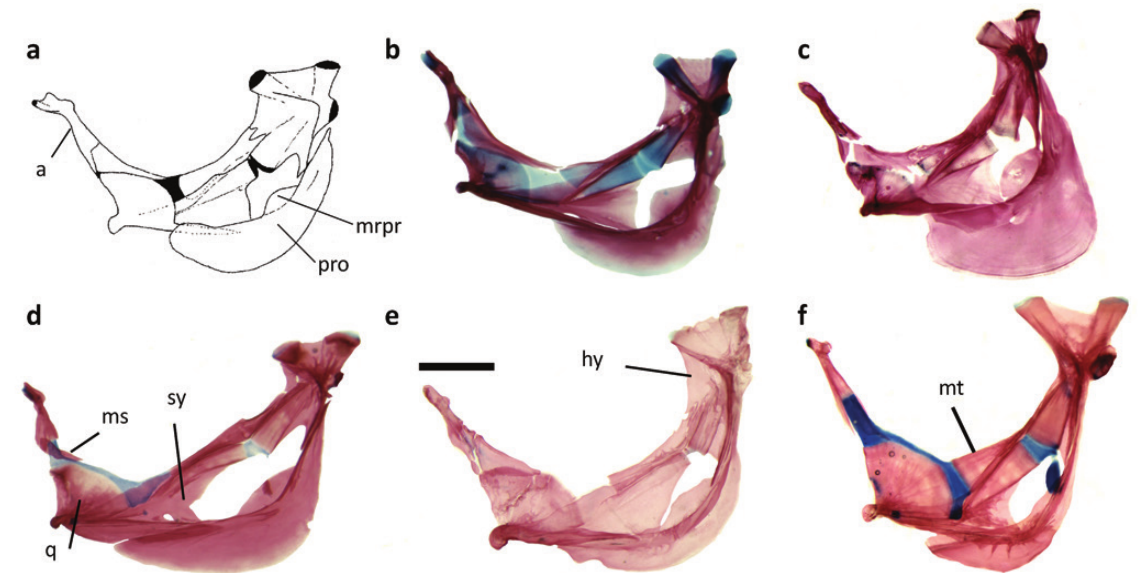
Fig. 1. Suspensorium of a. Kryptolebias caudomarginatus (Seegers) (modified from Costa, 1998), b. Pterolebias longipinnis Garman, c. Papiliolebias bitteri (Costa), d. Cynopoecilus melanotaenia (Reagan), e. Ophthalmolebias constanciae (Myers), f. Austrolebias vazferreirai (Berkenkamp, Etzel, Reichert & Salvia). “a” = autopalatine, hy = hyomandibula, “mrpr” = median rim of preopercle, “ms” = mesopterygoid, “mt” = metapterygoid, “pro” = preopercle, “q” = quadrate, “sy” = symplectic. Scale bar = 1 mm.